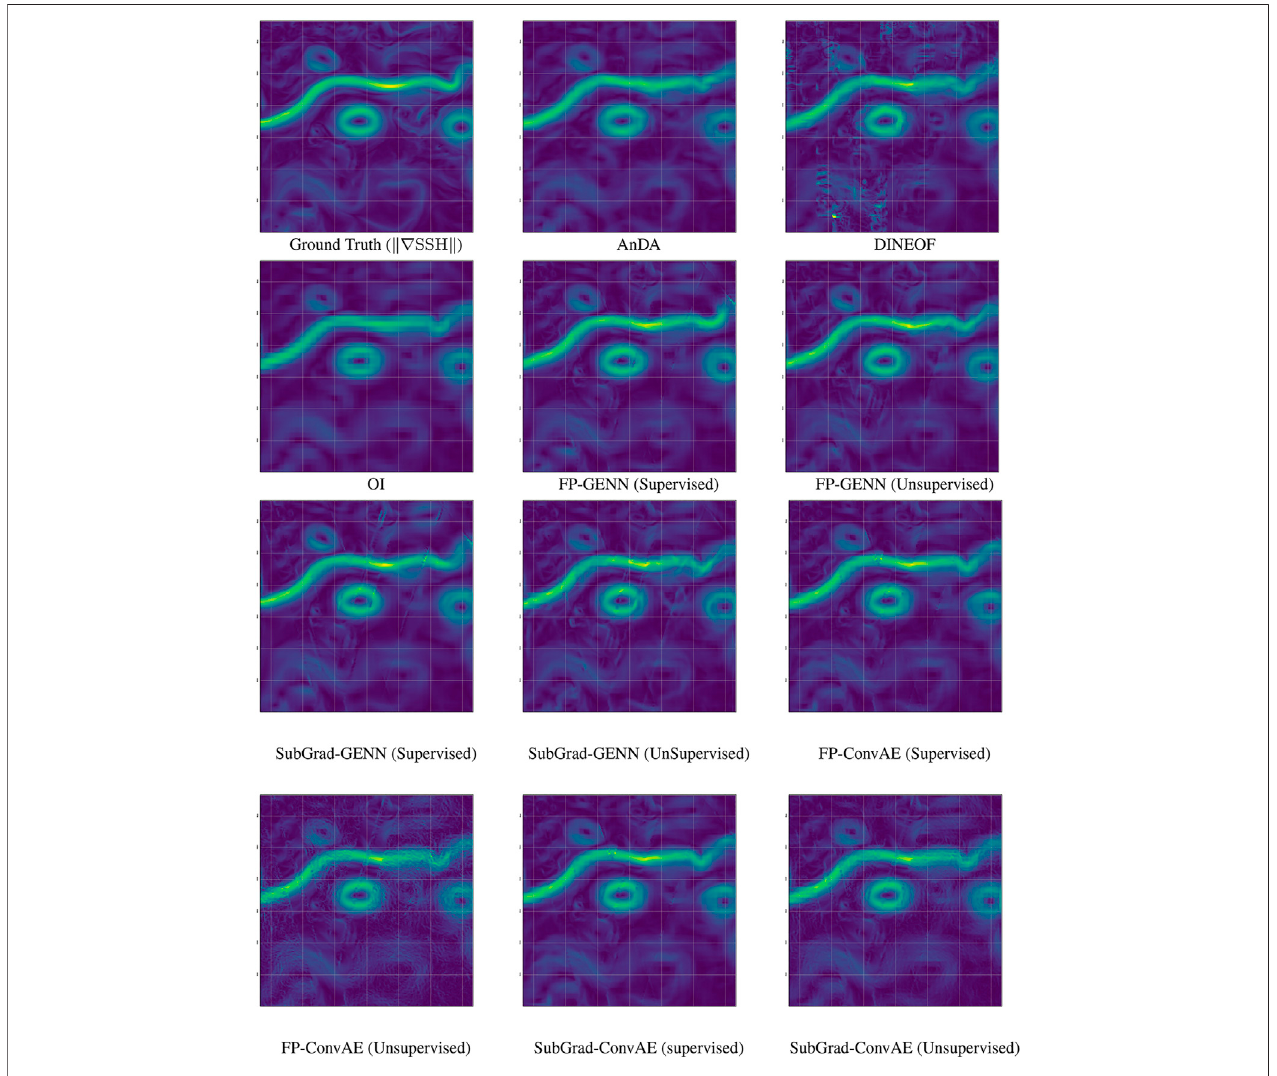
FIGURE 8 | Comparison of data-driven interpolation methods for the norm of the gradient of the SSH fi eld on April 8th, 2013: reference SSH fi eld (groundtruth), optimally interpolated fi eld (OI) (left panel), and data-driven interpolations of the SSH fi eld using DINEOF, AnDA, FP(5)-ConvAE, and FP(5)-GENN methods. We refer the reader to the main text for details on these